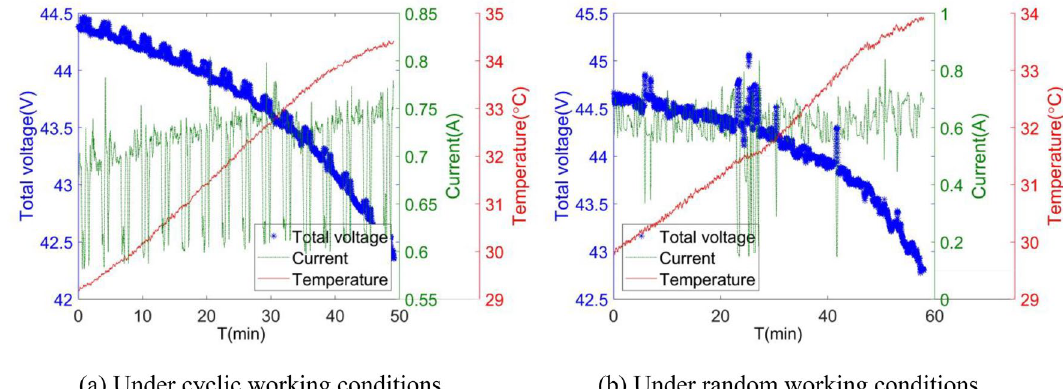
Figure 10 Experimental data under different working conditions